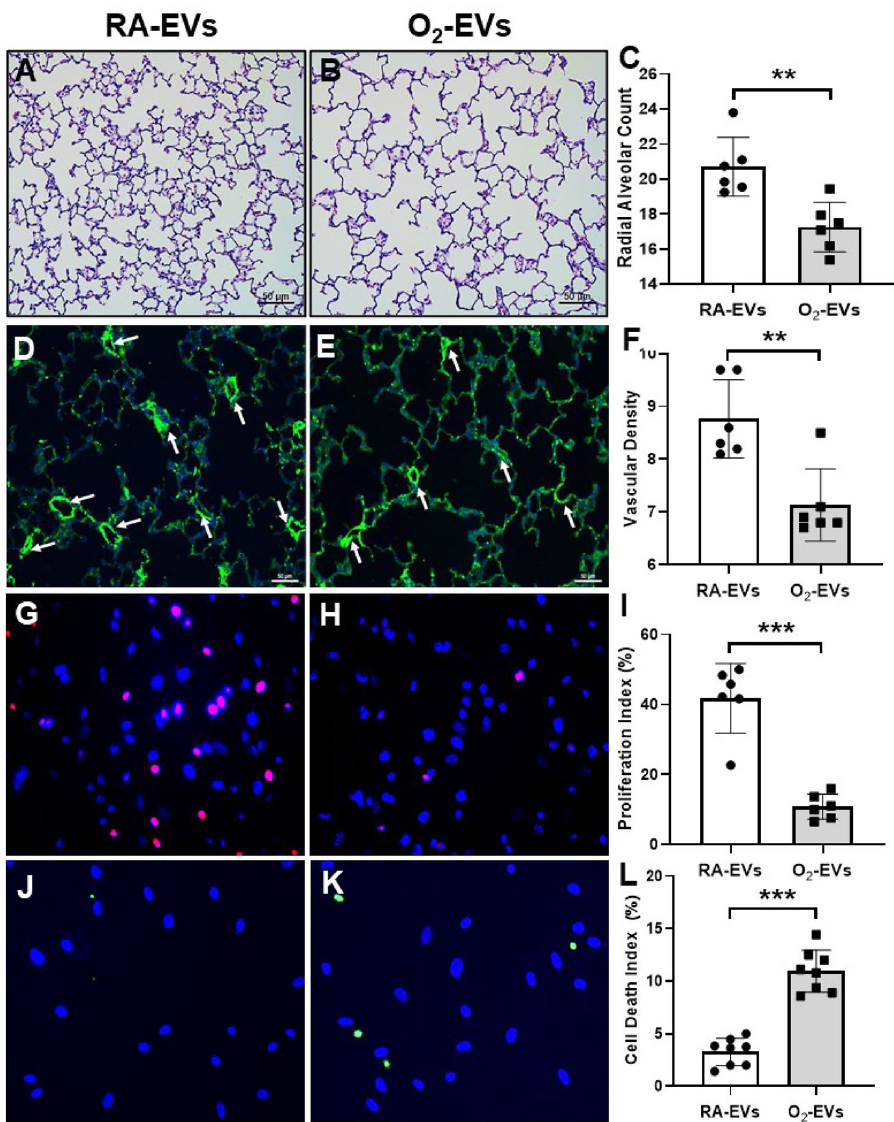
Figure 4. Circulating EVs from hyperoxia-exposed rats inhibit alveolar and vascular development in vivo and decrease cell proliferation and increase cell death in PVEC in vitro. H&E staining showed normal alveolar development in RA-EVs injected rats ( A ), but O 2 -EVs injected rats had larger and simplified alveolar structure ( B ). Scale bar: 50 µm. Morphometric analysis showed there was a decreased radial alveolar count (RAC) in O 2 -EVs injected rats as compared to RA-EVs injected rats (( C ), n = 6/group, ** P < 0.01). Immunofluorescence for vWF (an endothelial marker, green signals) and DAPI nuclear stain (blue signals) of lung sections from RA-EVs injected rats ( D ) and O 2 -EVs injected rats ( E ). Vascular densities (vessels < 50 µm in diameter, white arrows) were decreased in O 2 -EVs injected rats compared to RA-EVs injected rats (( F ), n = 6/group, ** P < 0.01). Scale bar: 50 µm. PVEC were cultured in the presence of RA-EVs or O 2 -EVs for 48 h. ( G ) and ( H ) Ki67 staining (pink signals) and DAPI nuclear staining (blue signals) showed decreased cell proliferation in O 2 -EVs treated PVEC compared to RA-EVs treatment (( I ), n = 6/group, *** P < 0.001). ( J ) and ( K ) TUNEL (green signals) and DAPI nuclear staining (blue signals) showed increased cell death in O 2 -EVs treated PVEC compared to RA-EVs treatment (( L ), n = 8/group, *** P <